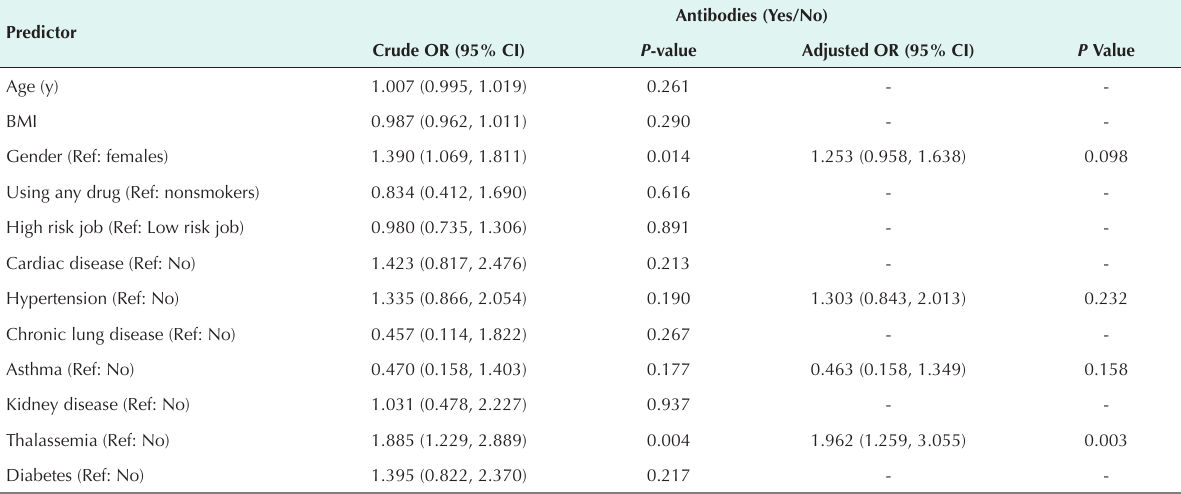
Antibodies (Yes/No)